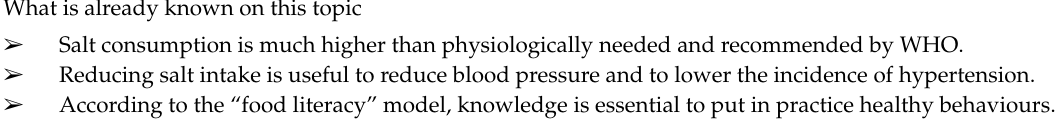
Table 2. Synthesis of the state of the art on the topic and of the conclusions of the